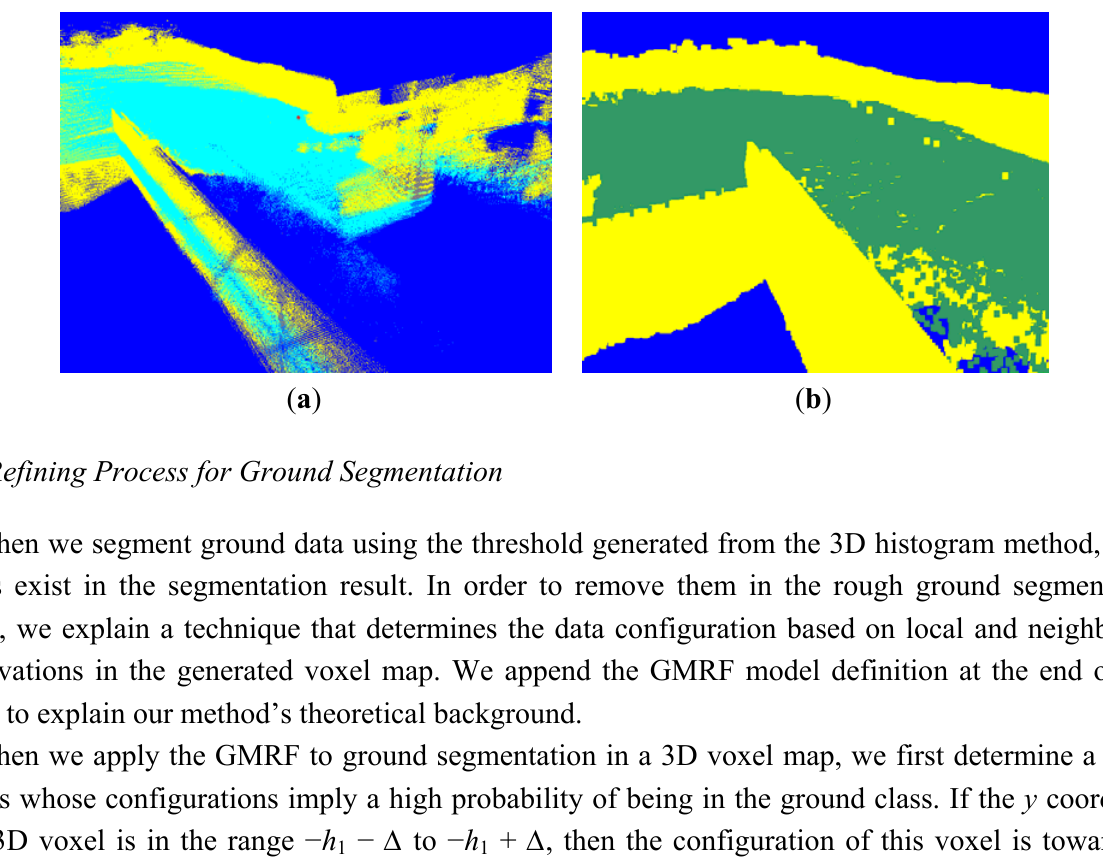
Figure 5. Ground segmentation in the voxel map. ( a ) Rough ground segmentation of the voxel map based on the height histogram. ( b ) Ground segmentation in the voxel map using the height histogram method with the proposed GMRF